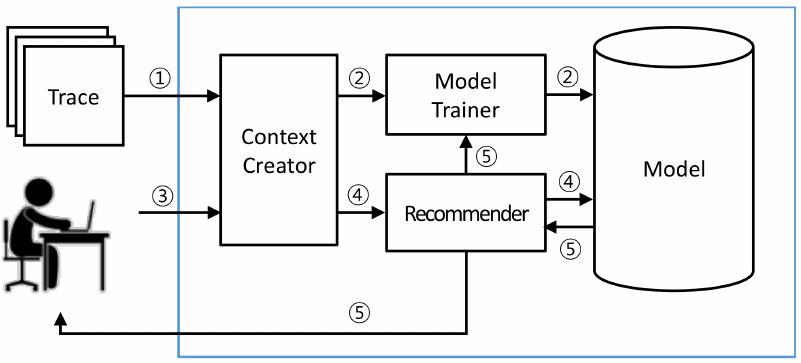
Figure 2. Architecture of the code edit recommendation system using a recurrent neural network